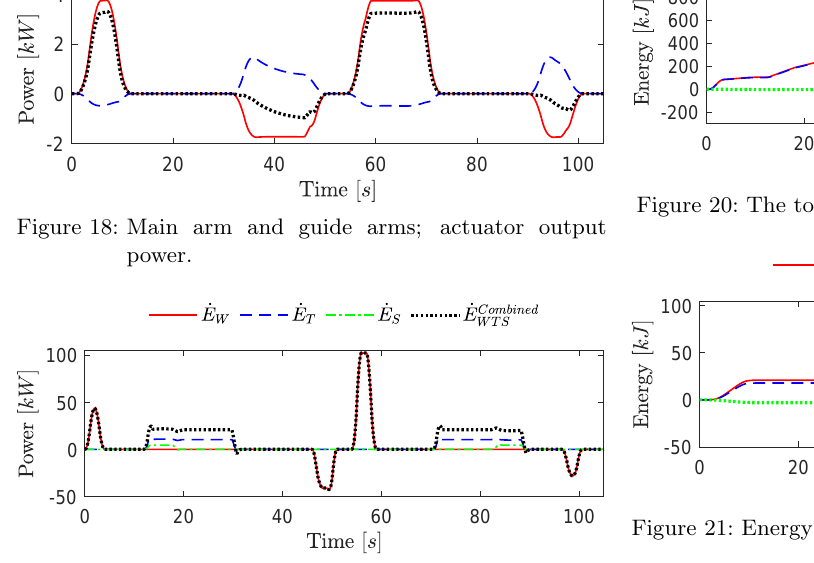
Figure 19: Winch, trolley and slew; actuator output power.